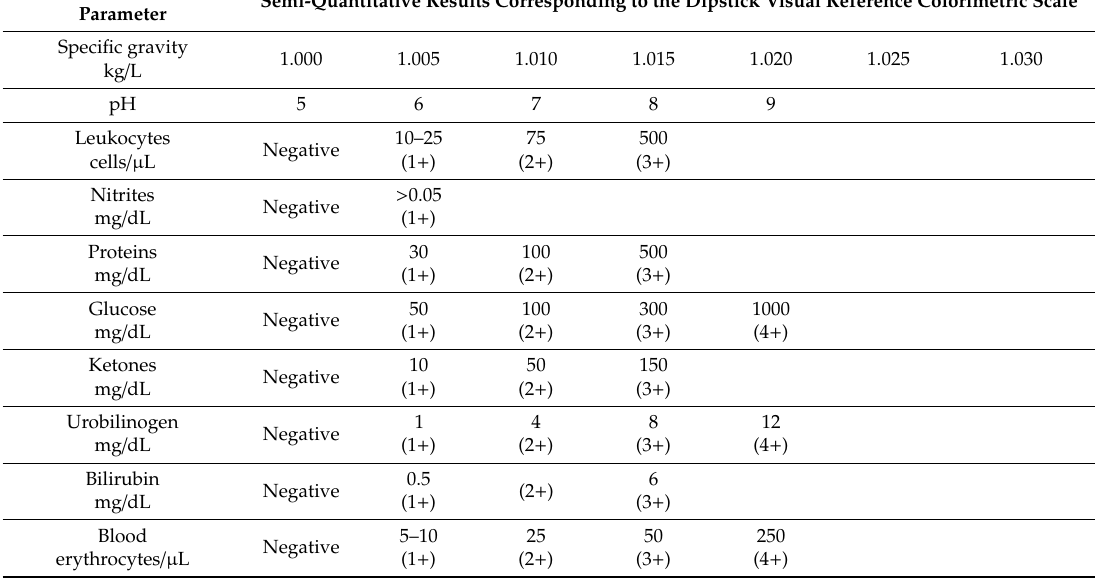
Table 1. Visual reference colorimetric scale corresponding to semi-quantitative results for each urinary parameter, as reported on the Combur-Test ®